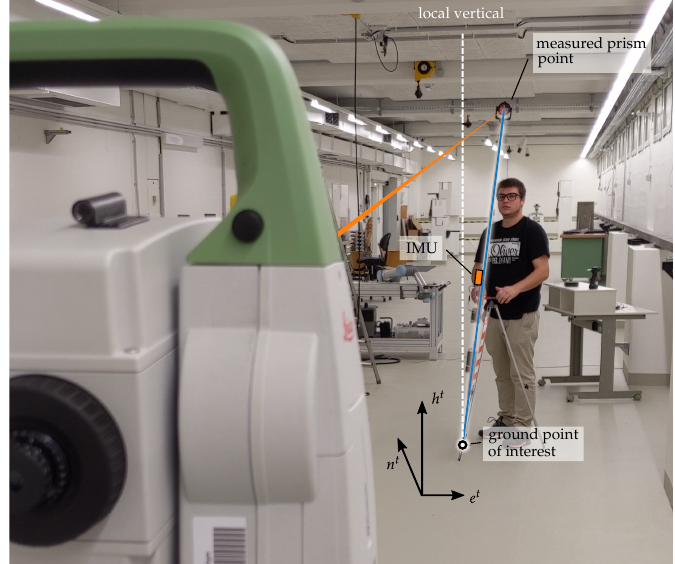
Figure 1. Illustration of pole tilt compensation for total stations. The ground point of interest w.r.t. the local geodetic frame is computed from the measured prism point using the estimated tilt from a pole mounted inertial measurement unit